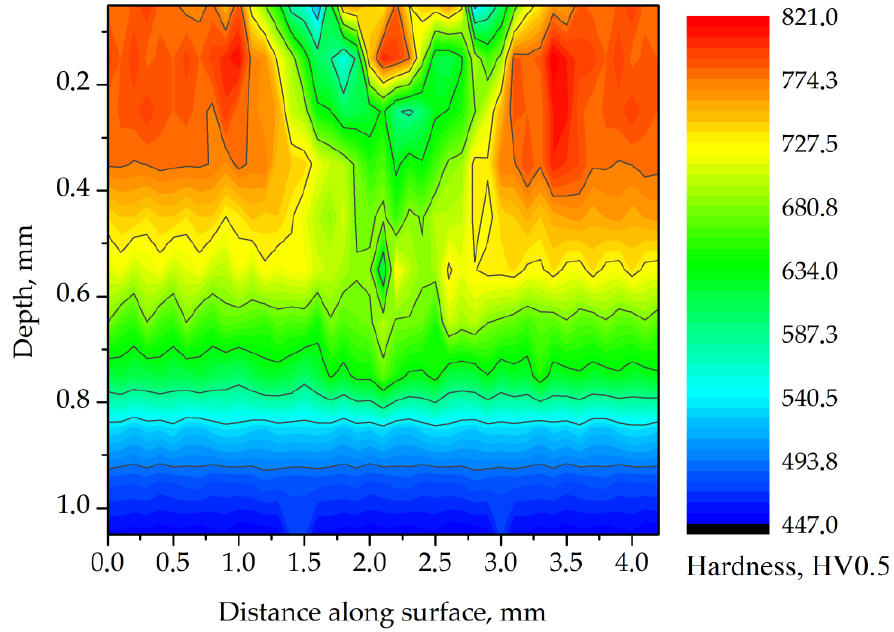
Figure 8. Hardness distribution for the cross-section of track 2. Processing parameters: laser beam power of 140 W; traverse speed of 750 mm·min −1 .